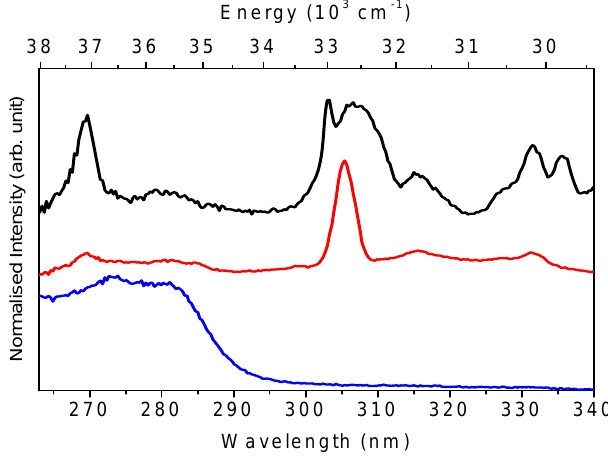
Figure 7. − 11 K excitation spectra of CeNT monitoring at 370.1 nm (black), 390.2 nm (red) and 450 nm